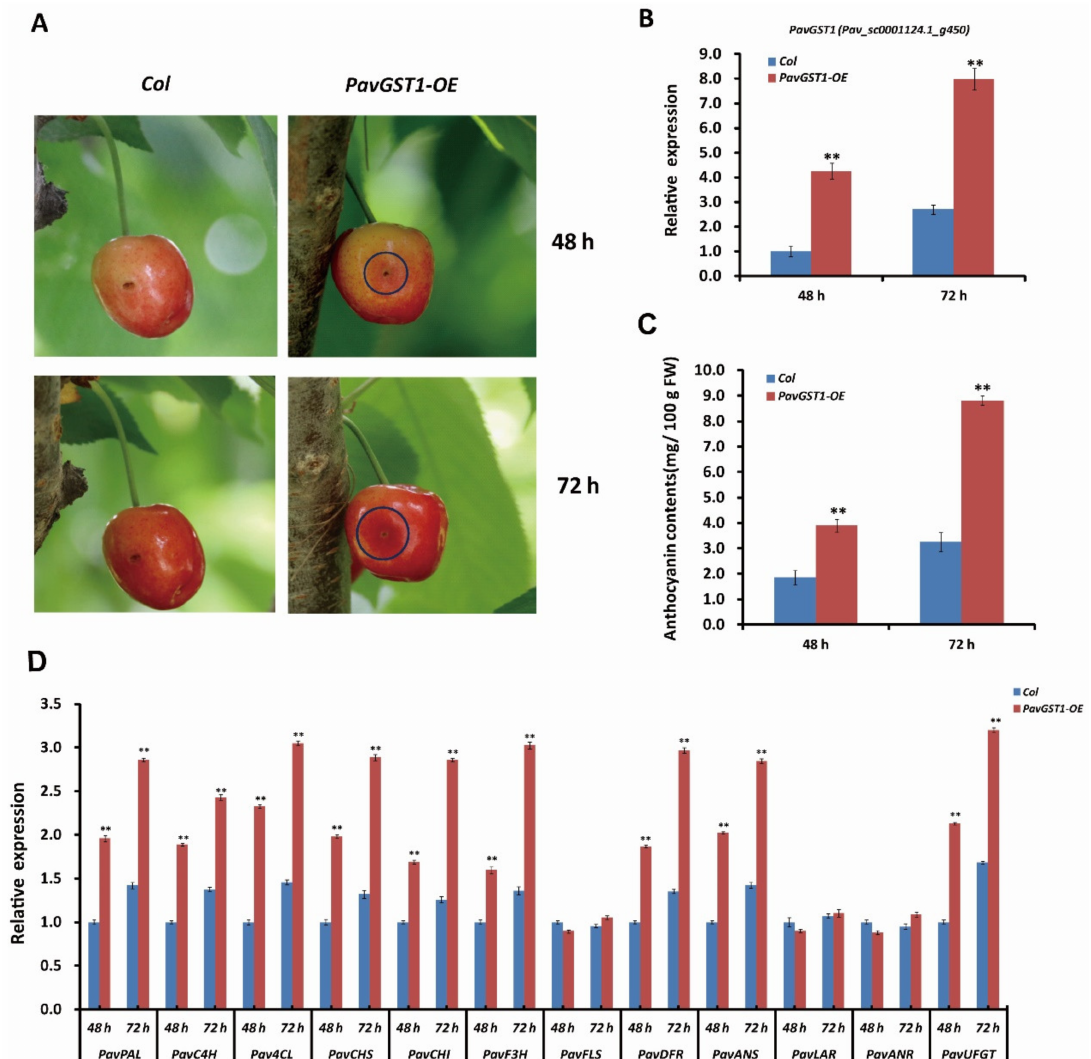
Figure 5. Enhanced anthocyanin accumulation in sweet cherry fruits resulting from transient expres- sion of PavGST1. ( A ) Phenotypes of PavGST1 transiently overexpressing fruits and control fruits recorded 48 and 72 h after inoculation in Chunlu sweet cherry varieties. ( B ) Results of qRT-PCR analysis of PavGST1 expression levels in PavGST1 transiently overexpressing fruits and control fruits. The Pavactin gene was used as an internal control. ( C ) Anthocyanin contents of PavGST1 transiently overexpressing fruits compared with the control. ( D ) Transcript levels of anthocyanin pathway genes in PavGST1 transiently overexpressing fruits and control fruits at 48 and 72 h after inoculation. Values represent means ± SD from six independent replicates. Statistical significance was determined using Student’s t -test (**, p <